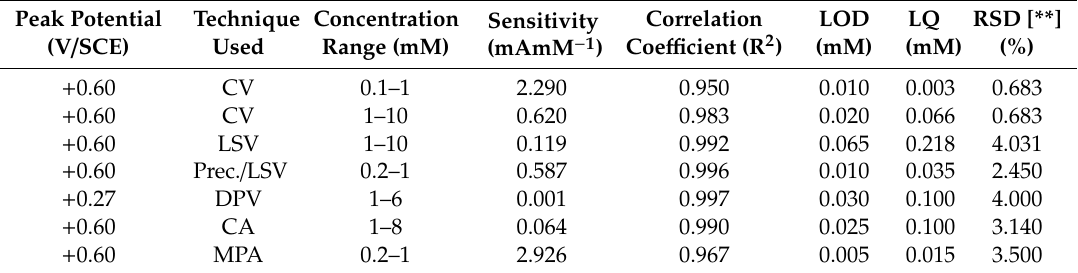
Table 2. The electroanalytical parameters for glucose direct detection at the MWCNT-CuBTC composite electrode in 0.1 M of NaOH supporting electrolyte.